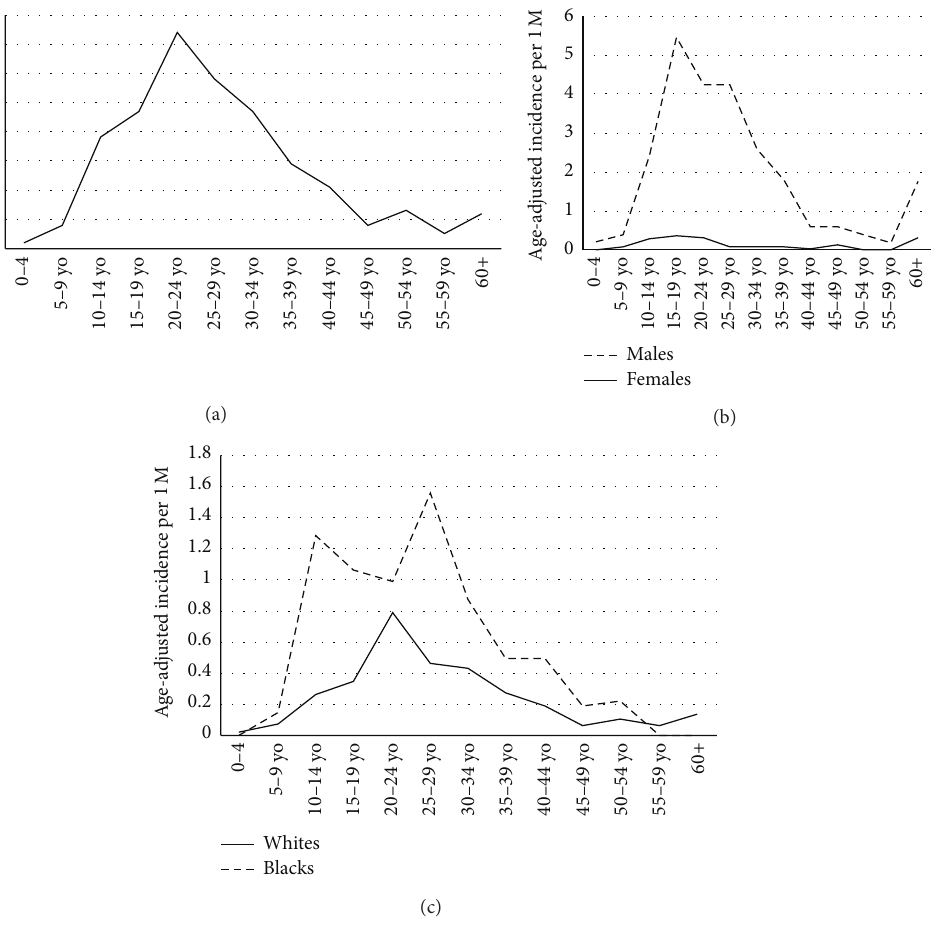
Figure 1: (a) Overall age-adjusted incidence of DSRCT. (b) Sex-based age-adjusted incidence of DSRCT. Males are more likely than females to get DSRCT ( 𝑃 < 0.001 ). (c) Race-based, age-adjusted incidence of DSRCT. Blacks are more likely than whites to get DSRCT ( 𝑃 = 0.037